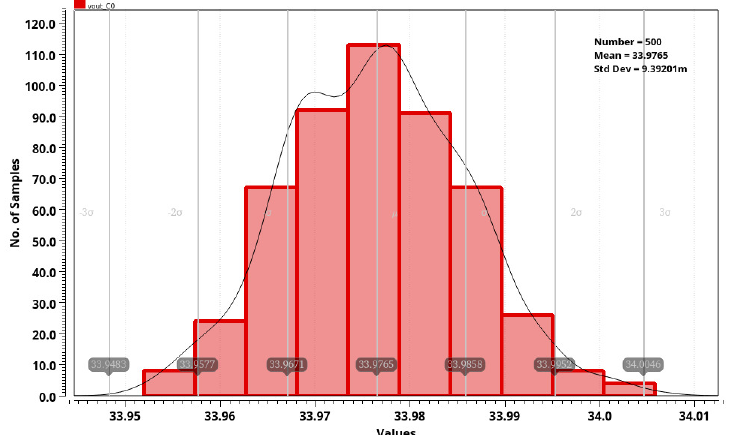
Figure 12. Monte Carlo simulation with A1A2 = 10, VBB = 24 V.